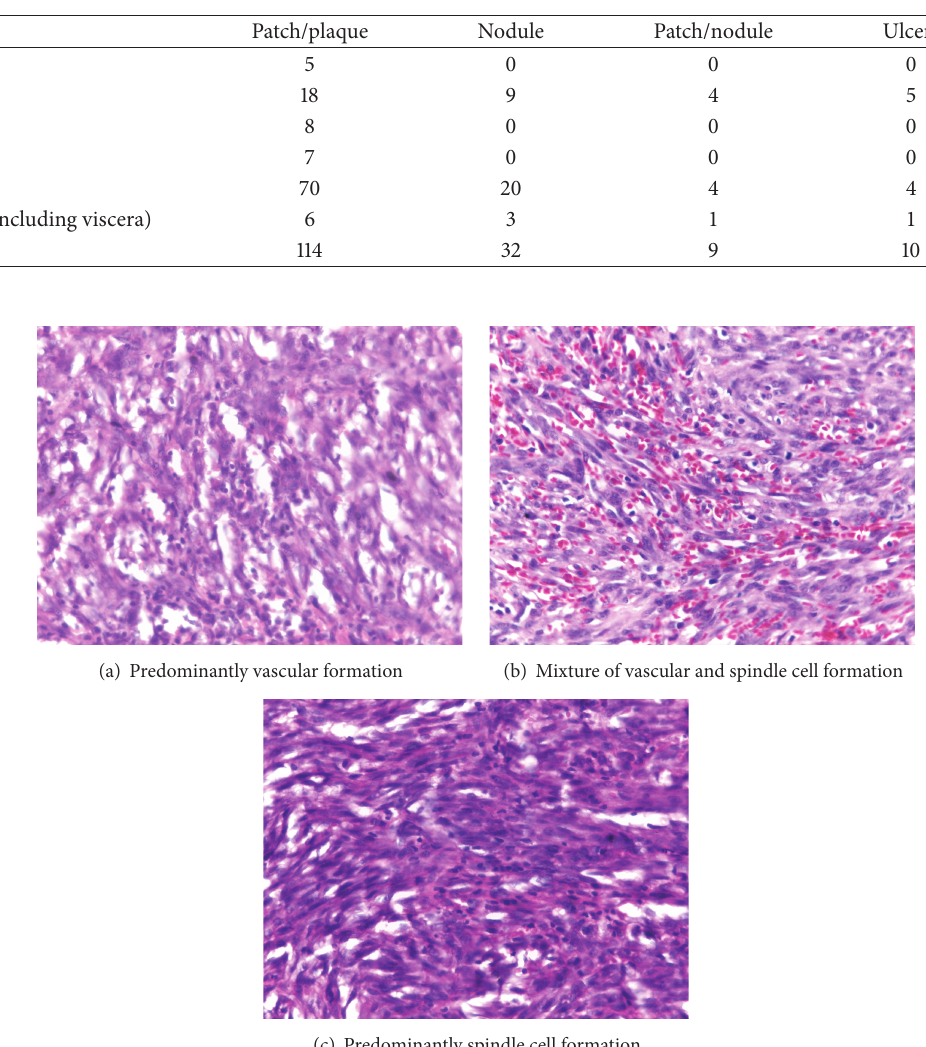
Figure 4: Histologic patterns of